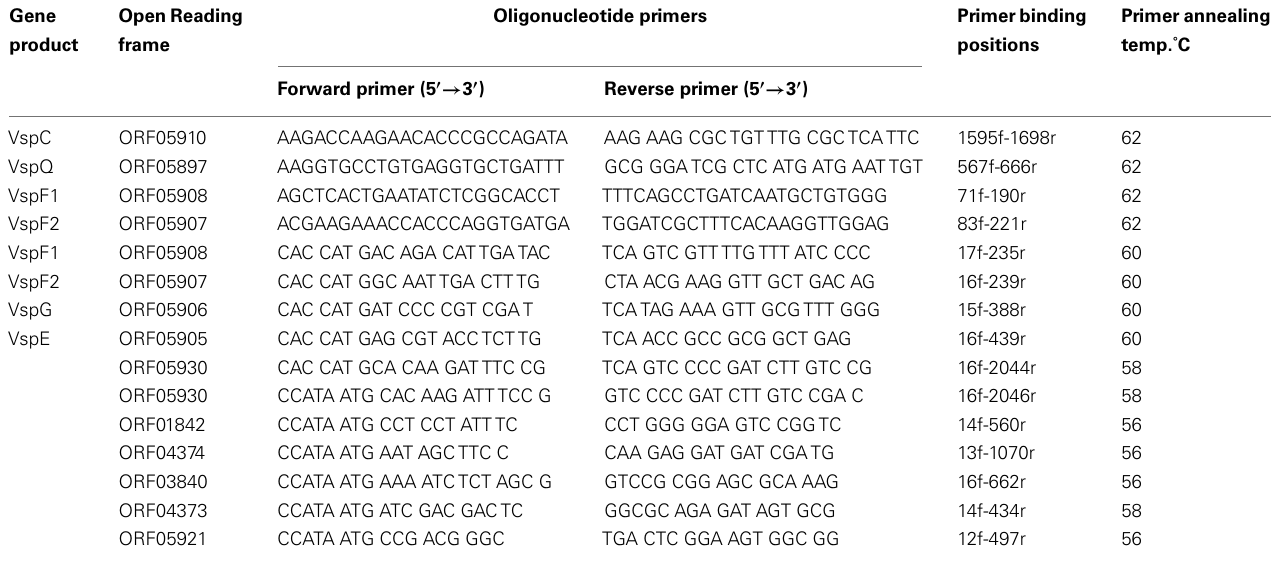
TableA3 | Oligonucleotide primers used in this